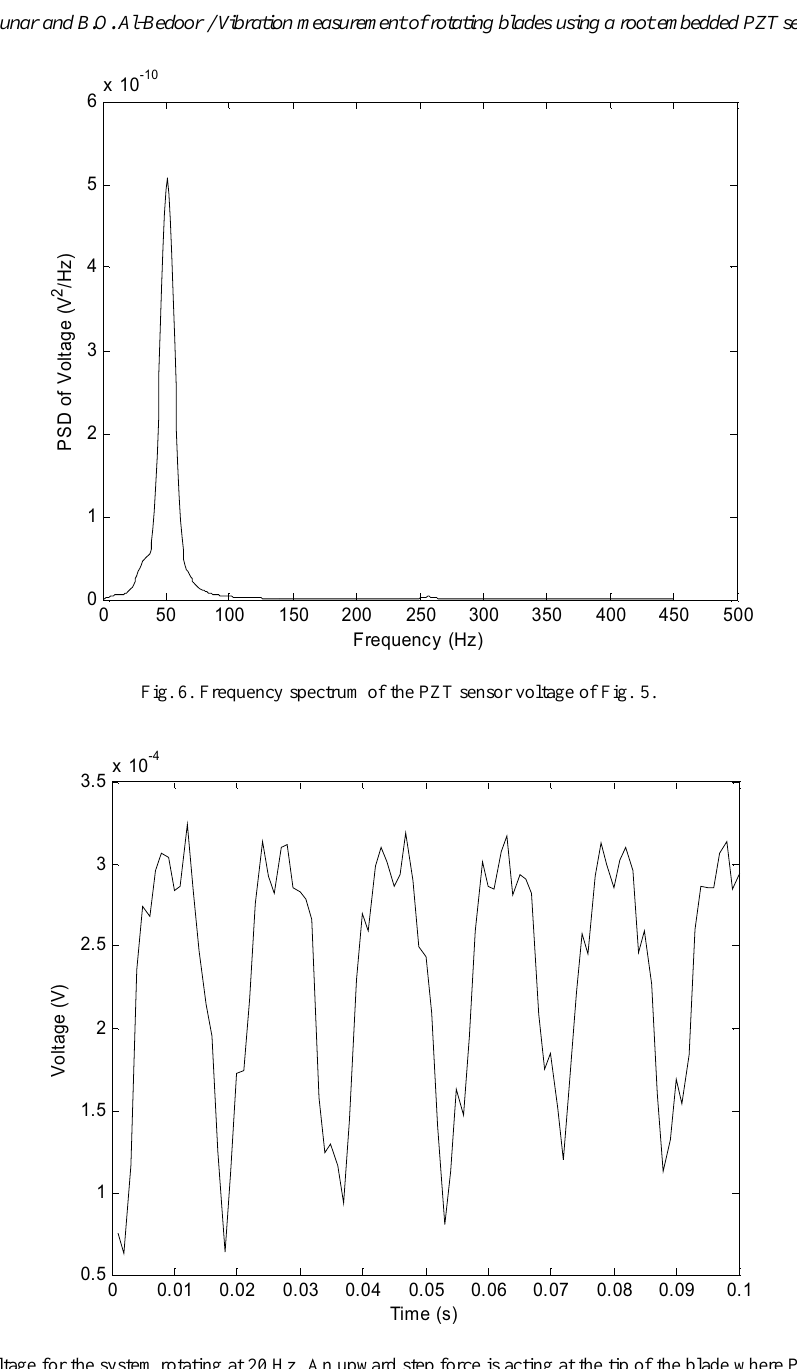
Fig. 7. PZT sensor voltage for the system rotating at 20 Hz. An upward step force is acting at the tip of the blade where PZT sensor is